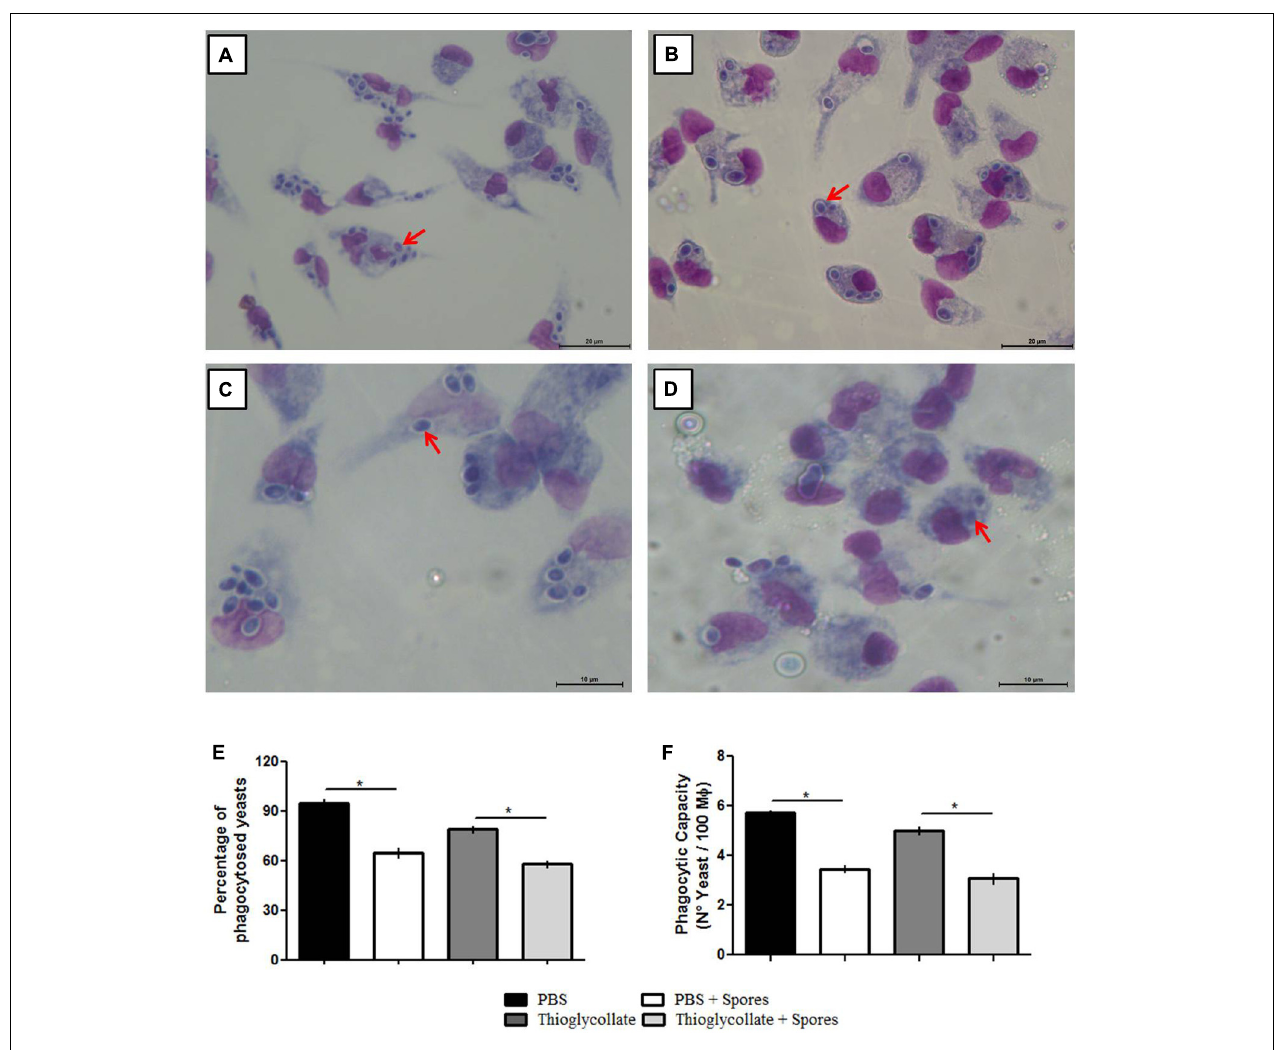
FIGURE 3 | Evaluation of C57BL/6 mice peritoneal phagocytosis treated with PBS (A) , PBS + spores (B) , thioglycollate (C) and thioglycolatte + spores (D) . Graphic bars represent the percentage of C. parapsilosis (ATCC 22019) yeasts phagocyted by 100 macrophages (E) and internalized by the macrophages (F) . Data represent as mean ± SD from three independent experiments with three mice in each group. ∗ p ≤